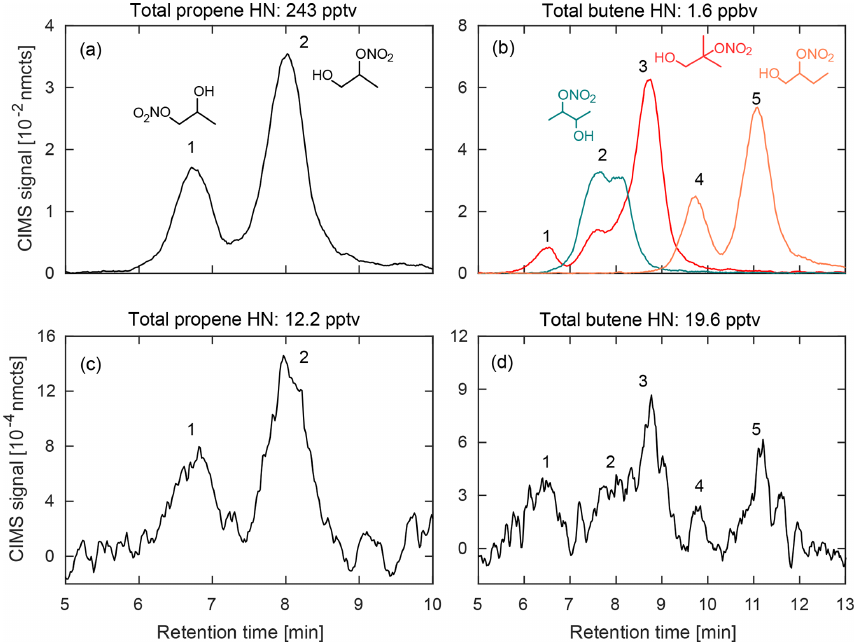
Figure 5. Comparison of hydroxy nitrates formed during chamber experiments (a–b) from propene (left) and three structural isomers of butene (right; 1-butene (orange), 2-butene (teal), and 2-methyl-propene (red); dominant hydroxynitrate structures shown) with the corre- sponding m/z signal observed during a 2017 field study in Pasadena, CA (c–d) . Data shown are a 10s